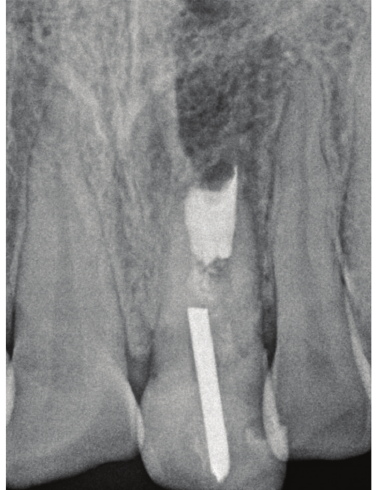
Figure 5: A follow-up radiograph at 12 months reveals a marked decrease of the periapical lesion, which was in the process of healing.